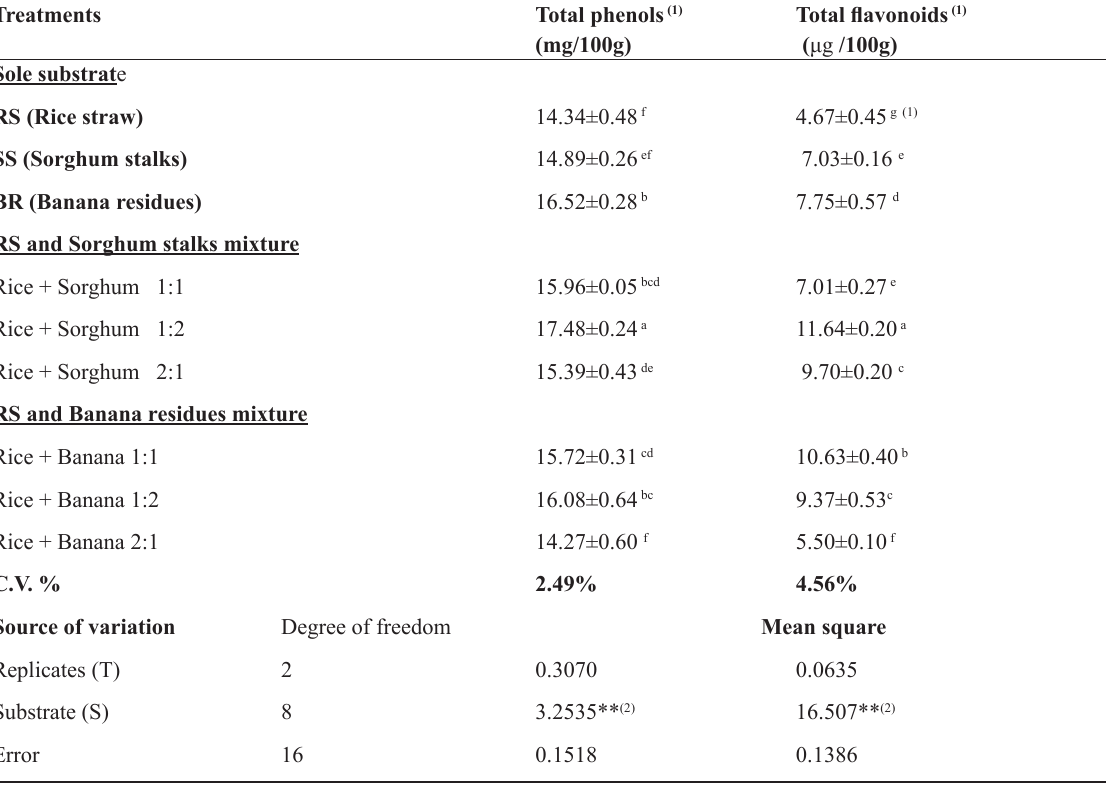
Table 2 Total phenols and flavonoids of oyster mushroom ( P. ostreatus ) produced on three sole substrates and six different mixtures of SS and BR with rice straw (RS) at 1:1, 1:2, and 2:1